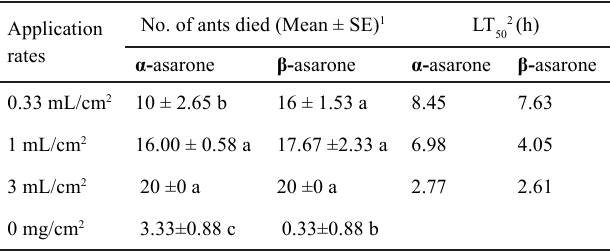
Table 3. Toxicity of α-asarone and β-asarone against Solenopsis invicta